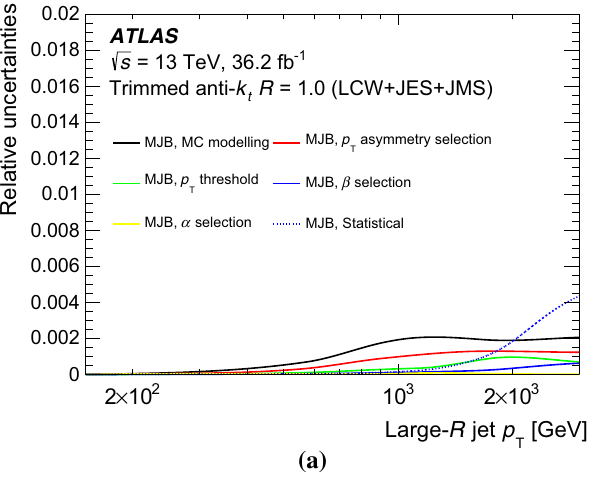
p jet R Large- [GeV] T parameter in combination, incorporating the weight of the method from which it originates. Since the multijet balance method relies on the small- R jet p T , nuisance parameters from all associated uncertainties are propagated. The lines shown are smoothed using a sliding Gaussian kernel